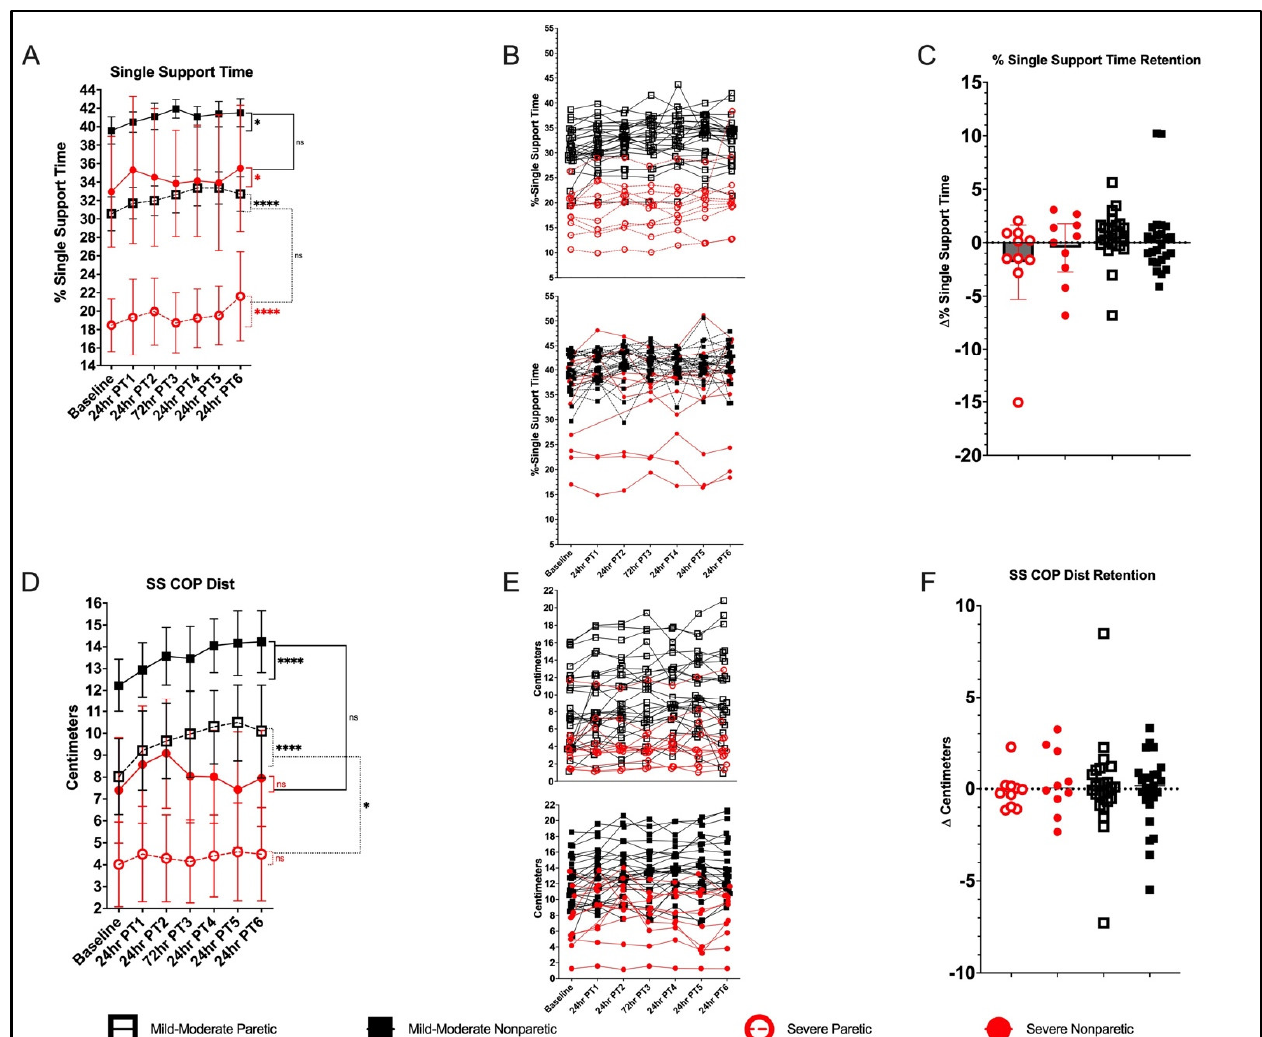
Figure 4. Overground walking performance (SST, SS COP Dist.). Mean progression in 10-mWT ( fast ) %SST paretic and nonparetic ( A ) individual values ( B ) and retention ( C ); SS COP Dist paretic and nonparetic ( D ), individual values ( E) and retention ( F ). Error bars show 95% CI; * p < 0.05; **** p < 0.0001.